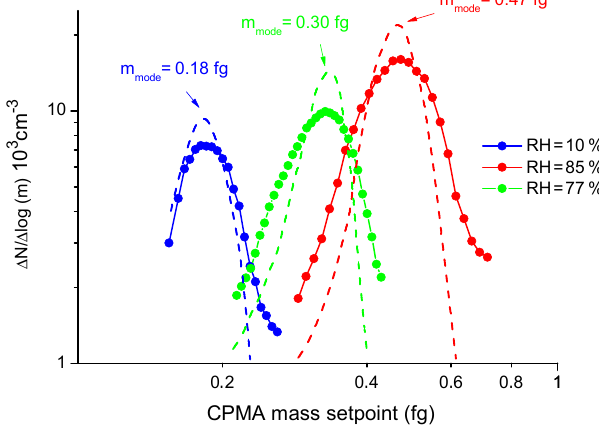
Figure 2. HCPMA measured particle number mass distribution of ammonium sulfate at different RH with initial dry particle modal mass m d = 0 . 18fg. The indicated m mode is the modal value of the particle mass distribution used for the mass growth factor ( G m ) cal- culation. Symbols and solid lines are experimental averaged mass spectral density (cid:49)N/(cid:49) log (m) . Dashed lines are mass-based distri- bution function d n/ dlog (m) after application of an inversion proce- dure to the primary